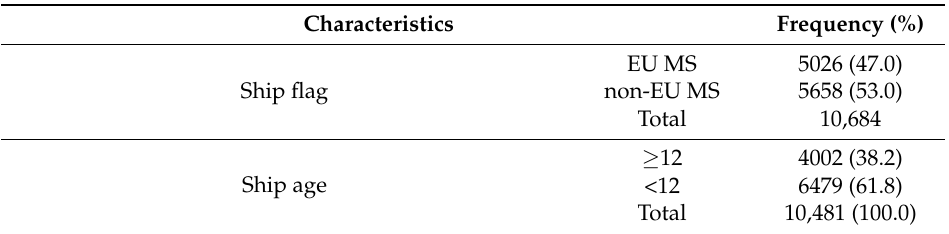
Table 1. Descriptive characteristics of ships and summary inspection